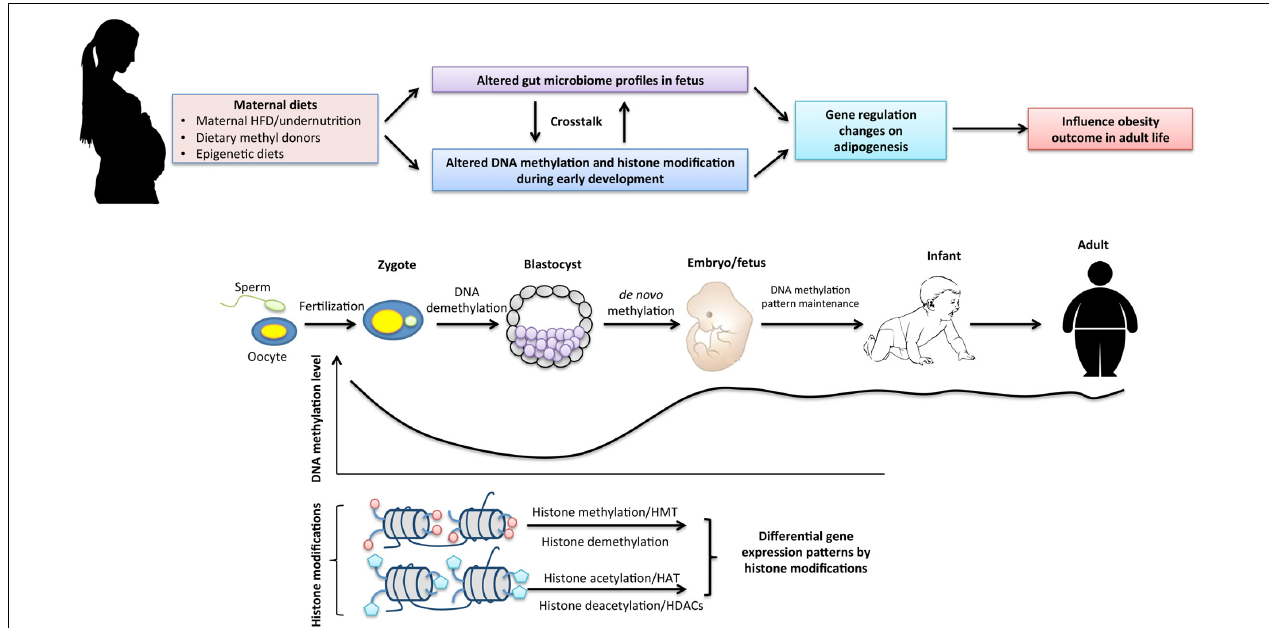
FIGURE 1 | The interaction of maternal dietary factors with early-life epigenetic mechanism and the gut microbiome in regulation of obesity in adult life. Epigenetics undergo dramatic changes during early embryogenesis. Genomic DNA undergoes global demethylation and subsequent de novo remethylation processes to maintain basal DNA methylation patterns throughout the life span. Histone modifications that maintain transcriptional regulations of cell-differentiation lineages during early development are mainly regulated by histone methylation and acetylation. Maternal nutritional status may affect early epigenetic reprogramming processes as well as early establishment of the gut microbiome in the fetus that result in gene expression changes on adipogenesis and metabolisms leading to altered phenotypes such as different susceptibility to obesity and obesity-related metabolic disease in adult